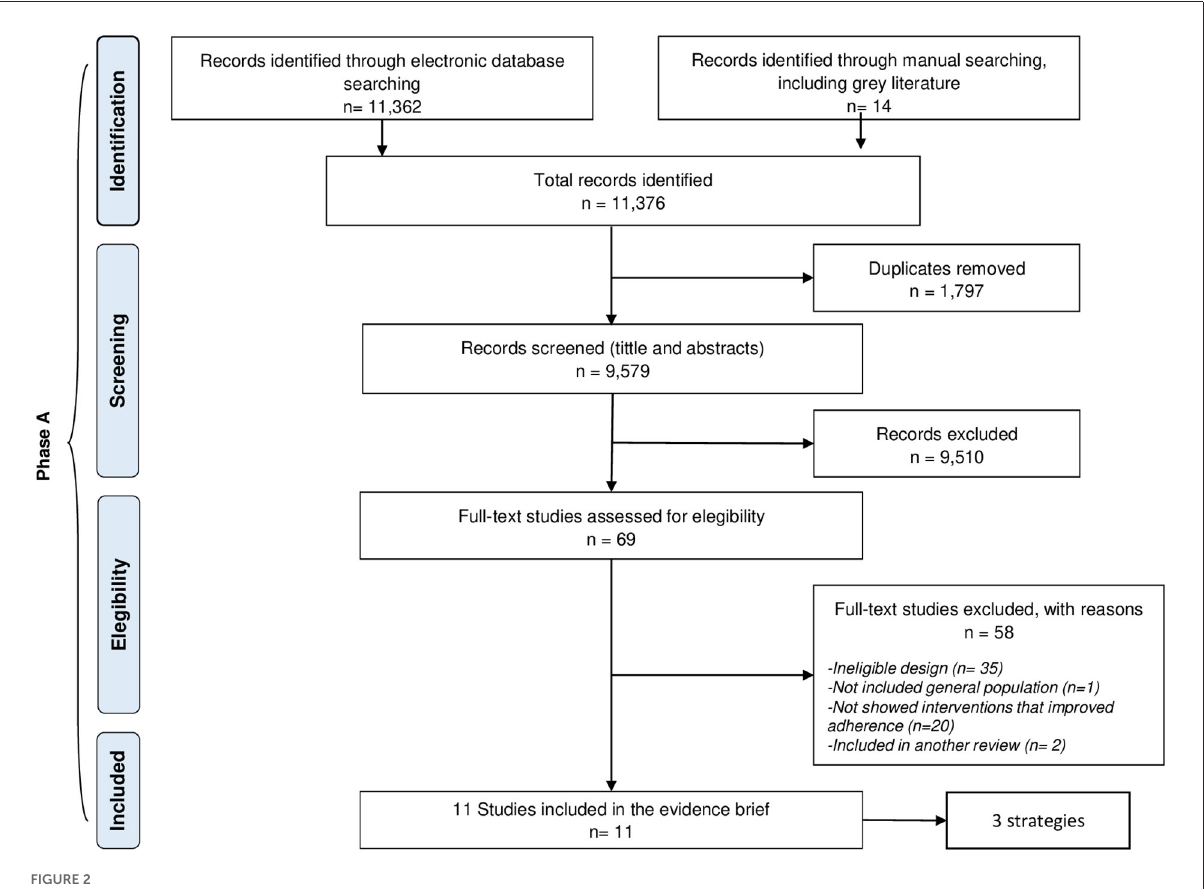
FIGURE2 Selection of